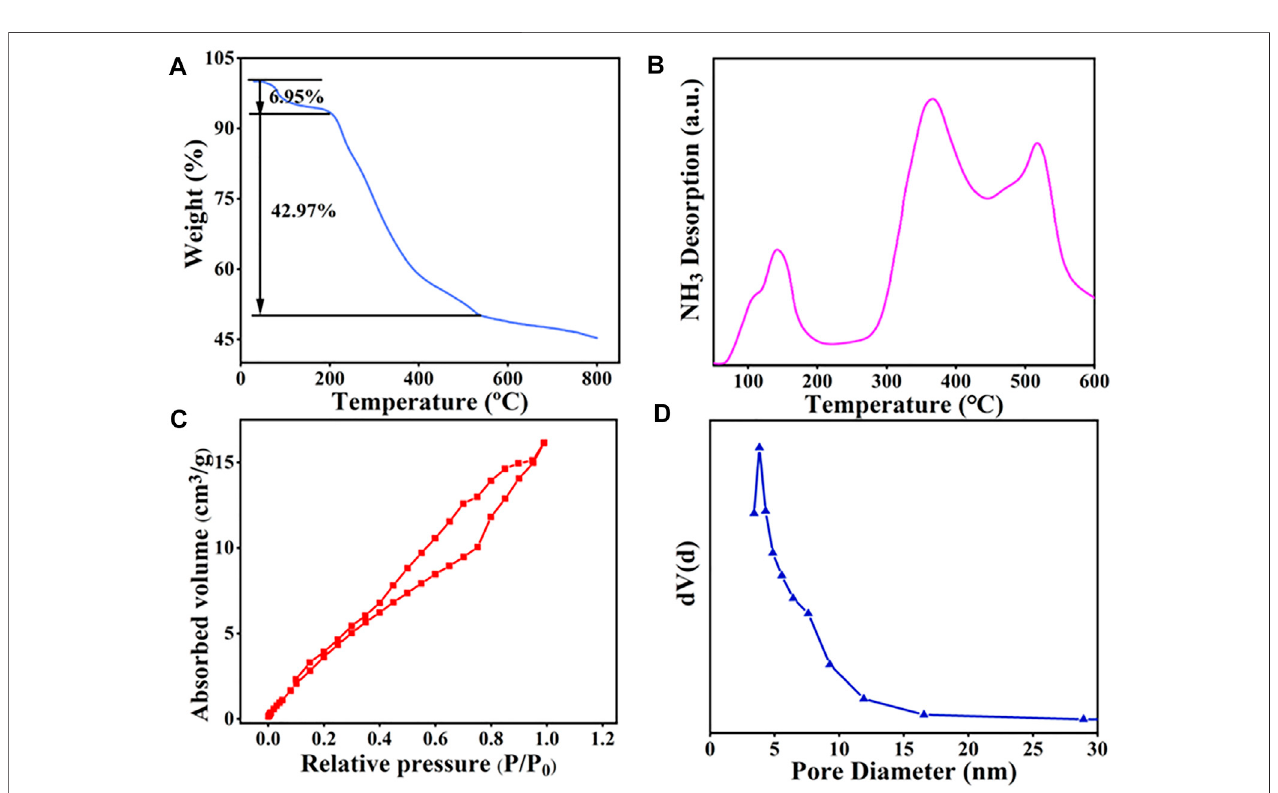
FIGURE 2 | SiO 2 @Cs-SO 3 H catalyst diagram of (A) TGA, (B) NH 3 -TPD, (C) BET, and (D) pore size distribution.